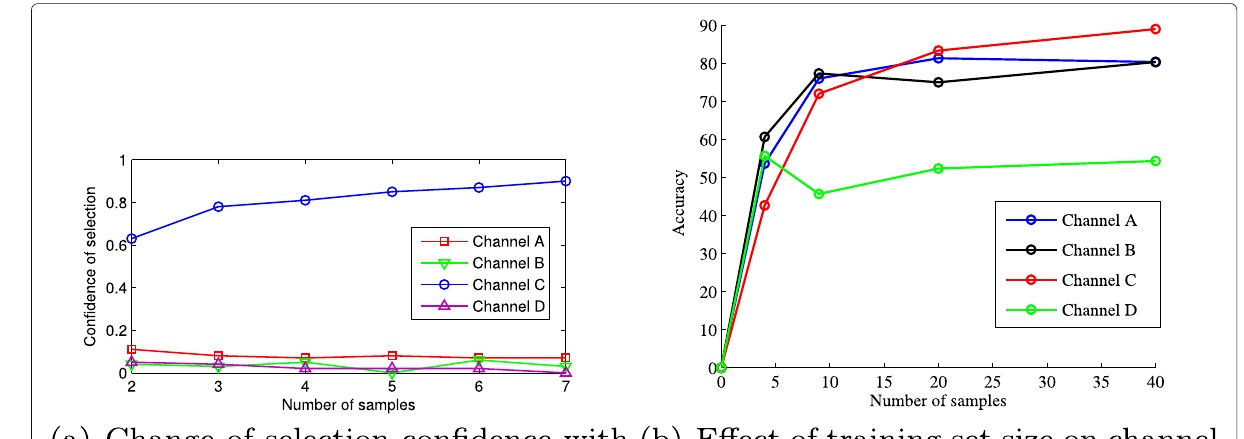
Fig. 8 Effect of data volume on channel inference performance. a The impact of number of available samples on channel-inference confidence. b The effect of training set size on channel inference